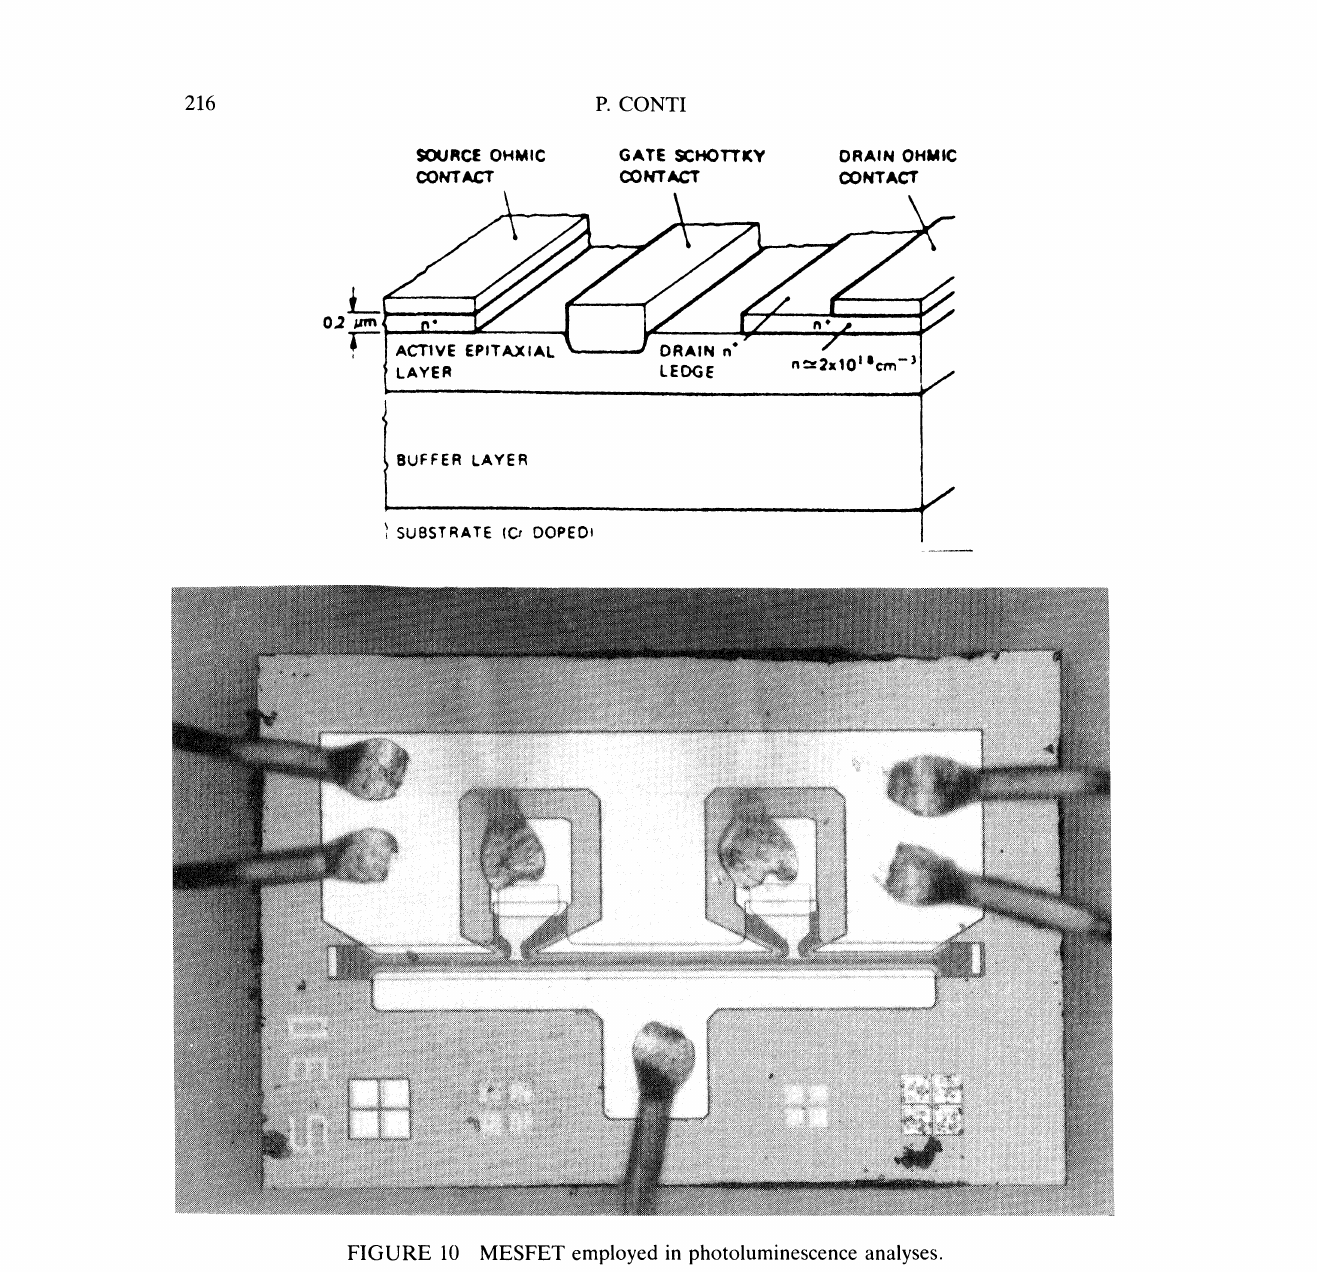
FIGURE 10 MESFET employed in photoluminescence